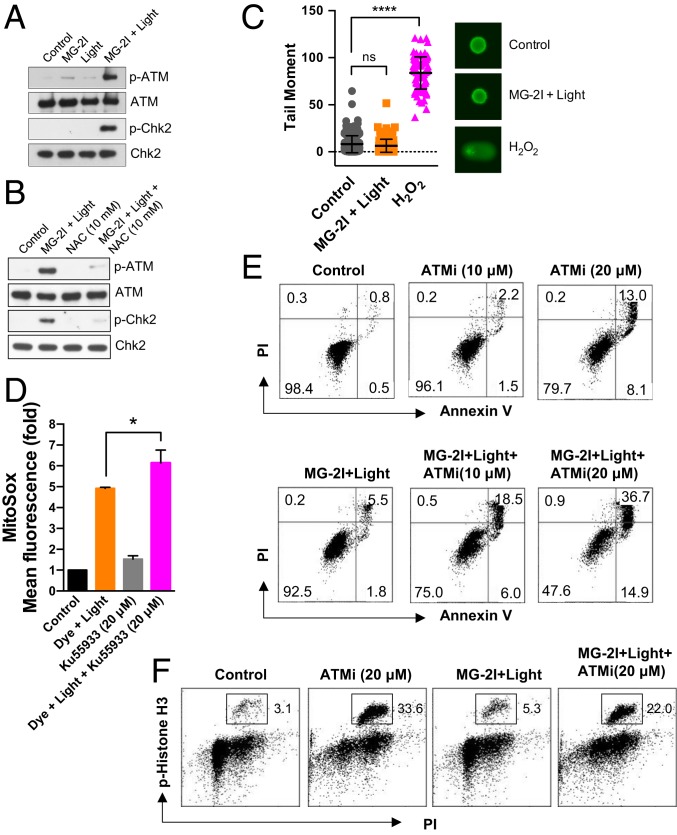
Activation of the ATM pathway in response to oxidative stress after MG-2I and light treatment. (A) At 24 h after MG-2I (50 nM) and light (5-min) treatment, phosphorylation of ATM and Chk2 was determined by western blot. (B) Cells were treated with NAC (10 mM) for 15 min before, during, and after exposure to MG-2I dye (50 nM) and light (5 min). At 24 h postexposure, the phosphorylation of ATM and Chk2 was determined by western blot. (C) DNA single-strand breaks were determined by alkali Comet assay 24 h after treatment with light (5 min) in the presence of MG-2I (50 nM). Treatment of 100 μM H2O2 for 20 min served as a positive control. Data are represented as mean ± SEM. Control (n = 235), MG-2I + Light (n = 263), and H2O2 (n = 91). ns, not significant. ****P < 0.0001. (D) Cells were treated with ATM kinase inhibitor KU-55933 alone, MG-2I (50 nM) plus light (5 min), or MG-2I plus light exposure in the presence of KU-55933. The generation of mitochondrial superoxide was determined 4 h after treatment by MitoSox. Data are represented as mean ± SEM. *P < 0.05. (E) Cells were treated in a manner as described in D, and the apoptosis was determined 72 h after MG-2I and light treatment. (F) The number of cells in mitosis was measured by the phosphorylation of histone H3 24 h after treatment.